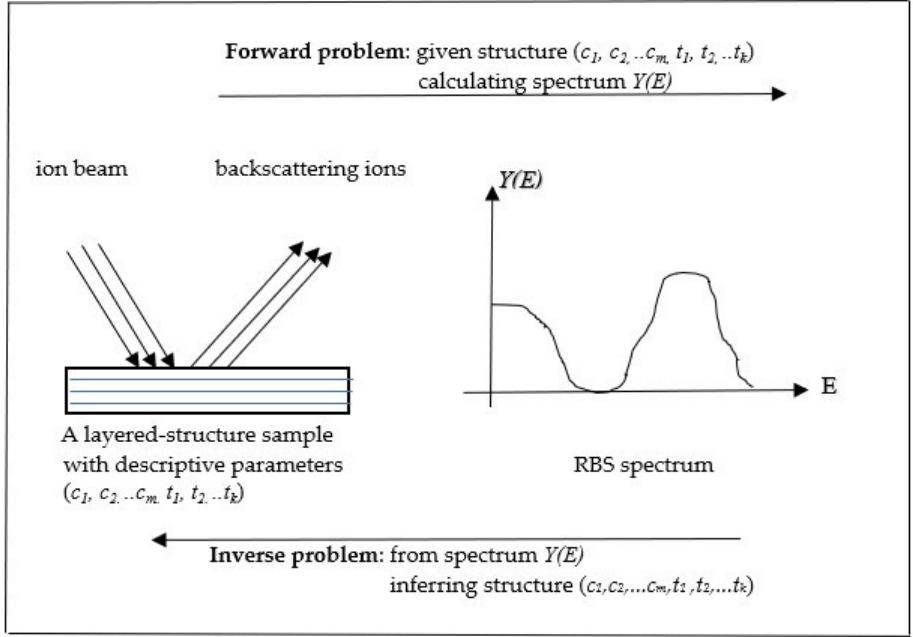
Figure 1. Rutherford backscattering spectroscopy (RBS) backscattering process and the definition of the inverse problem.